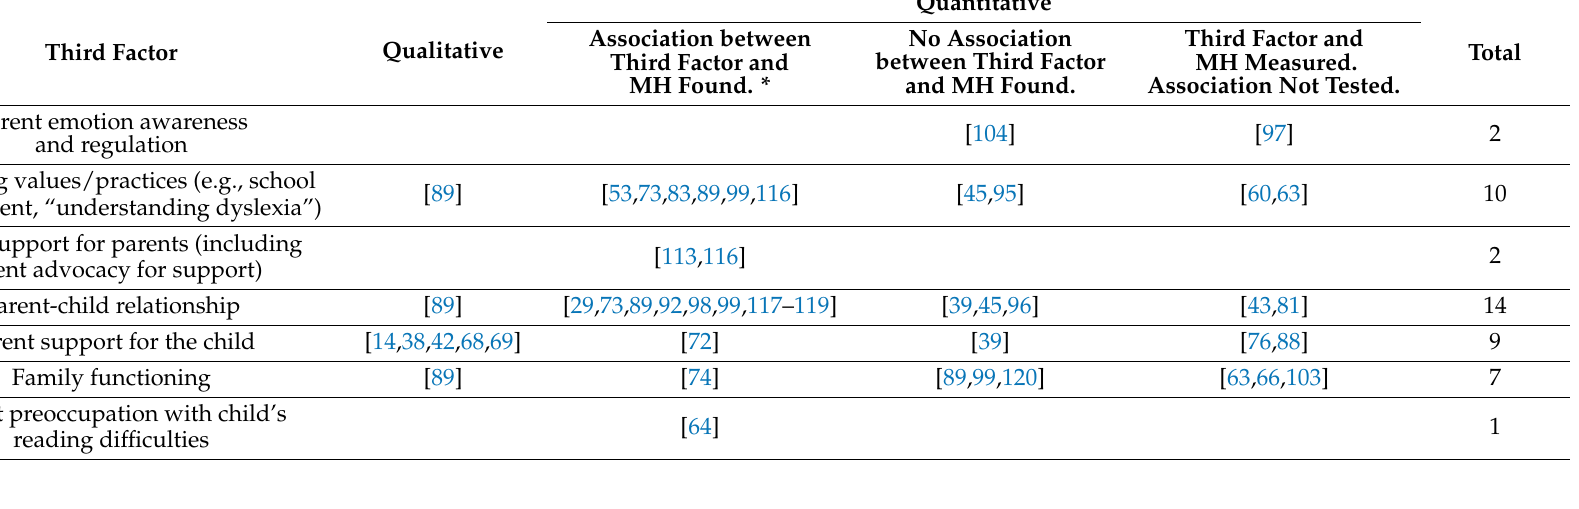
Quantitative No Association between Third Factor and MH Found.